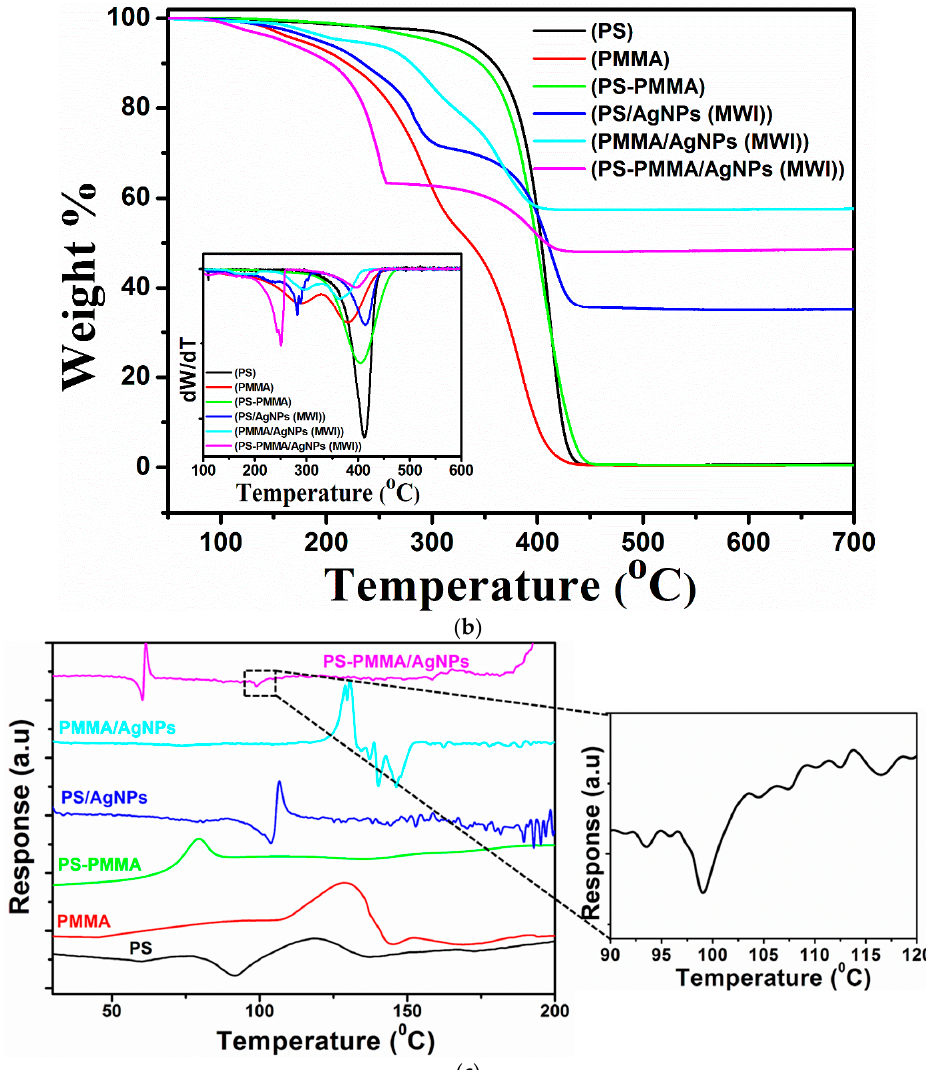
Figure 9. ( a ) TGA thermograms of polymer/AgNPs nanocomposites using MWI and in situ method; ( b ) TGA thermograms of neat polymers and polymer/AgNPs nanocomposites using MWI; ( c ) DSC thermograms of polymer/AgNPs nanocomposites and neat polymers. Bottom right: enlarged image of area marked by a box.